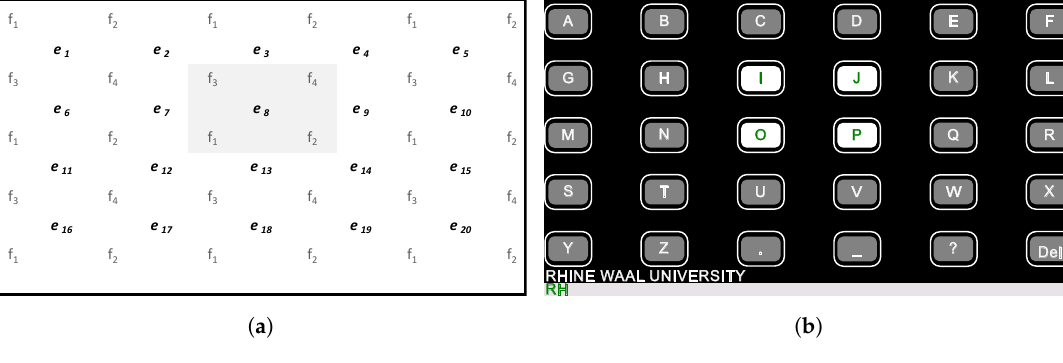
Figure 3. Frequency arrangement for the Hybrid . Stimuli f 1 = 6.00 Hz, f 2 = 6.67 Hz, f 3 = 7.5 Hz and f 4 = 8.57 Hz were used. Initially one of twenty gaze boxes e i was determined using the eye tracker ( a ). If, e.g., the box e 8 was classified, the four buttons “I,J,O,P” started to flicker allowing the selection of an individual letter via steady state visual evoked potentials ( b